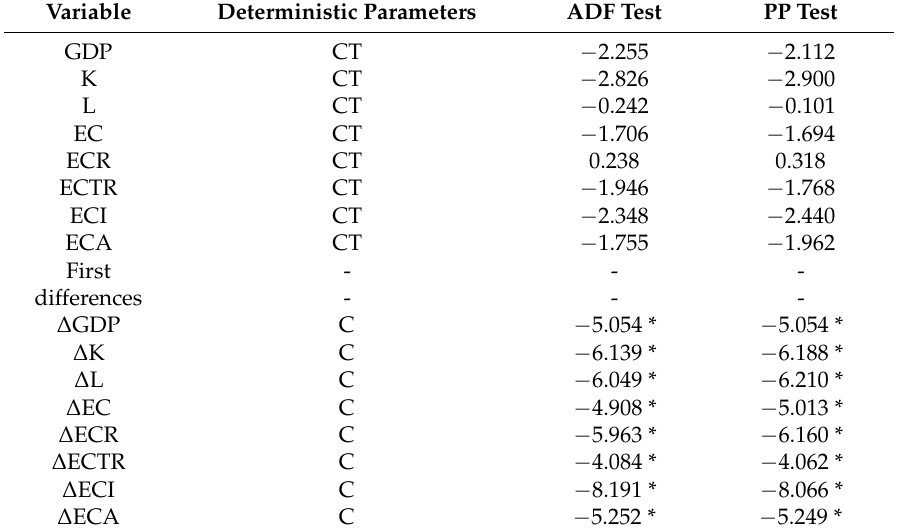
Table A1. Unit root tests without structural breaks.